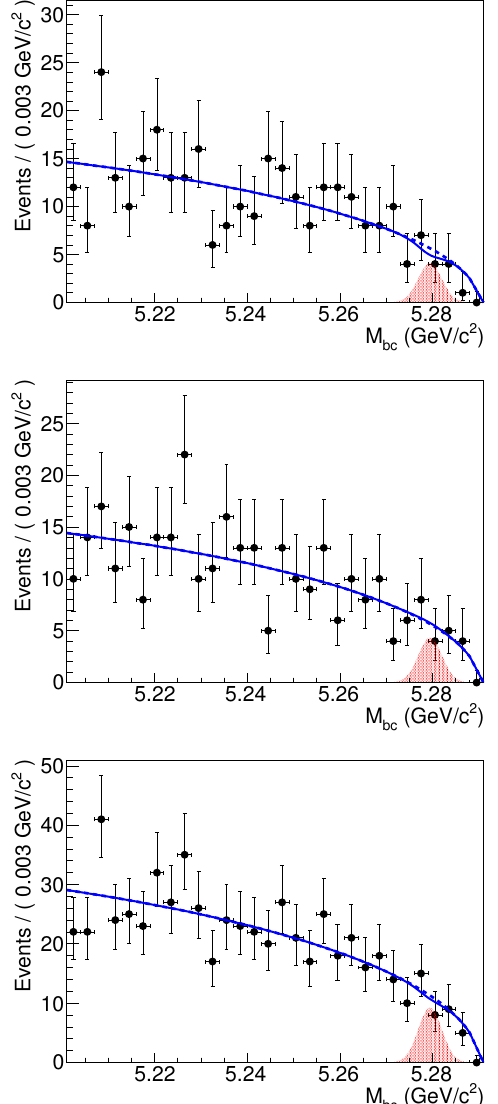
Figure 6: The M bc distributions for data events that pass the selec- tion criteria for the decays B 0 → K ∗ 0 µ + e − (top), B 0 → K ∗ 0 µ − e + (middle), and also both decays combined (bottom). Points with er- ror bars are the data, and the blue solid curve is the result of the fit for the signal-plus-background hypothesis, where the blue dashed curve is the background component. The red shaded histogram represents the signal PDF with arbitrary normalization.